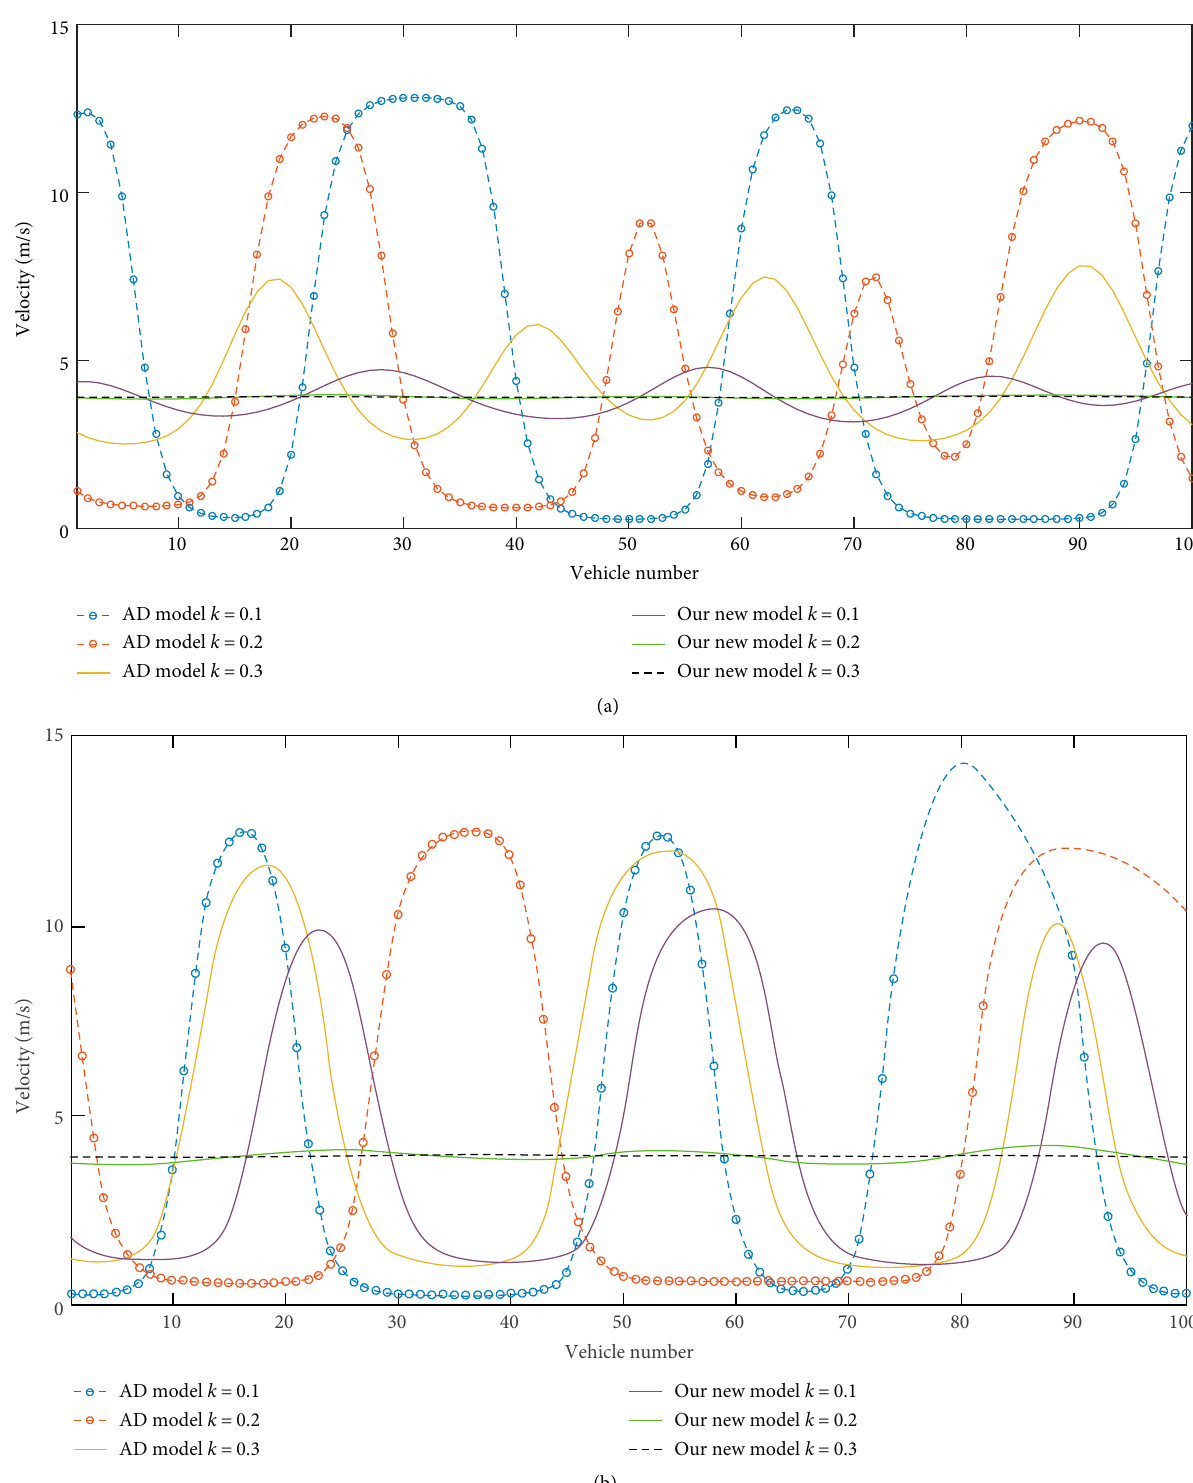
Figure 7: Snapshots of velocities of 100 vehicles simulated by AD and AMD models with different values of (a) t = 1000s, and (b) t =